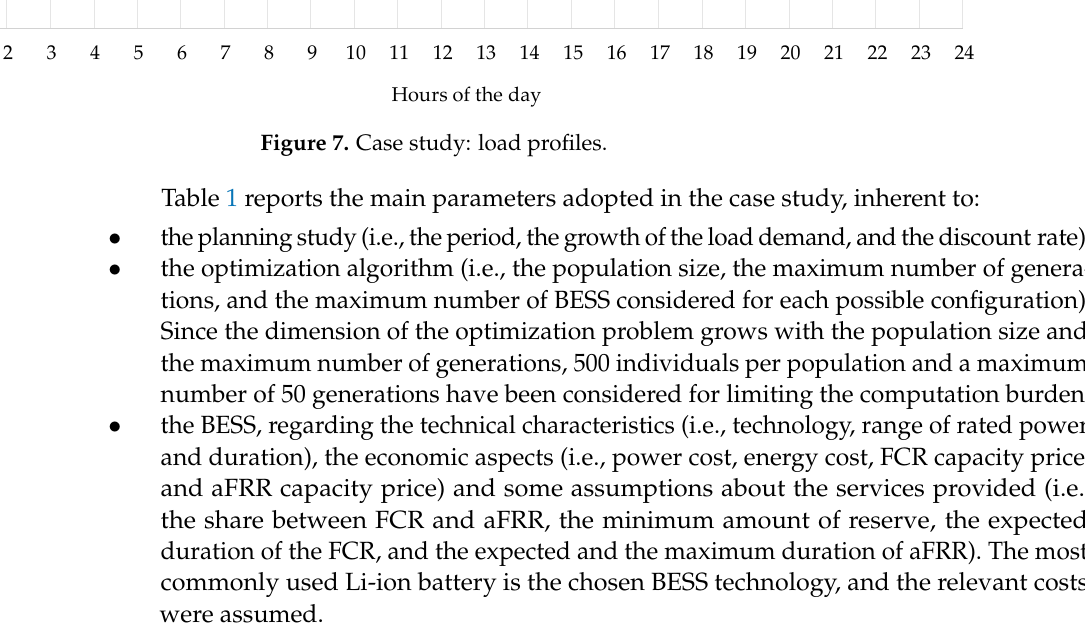
Table 1. Main parameters used for the study.